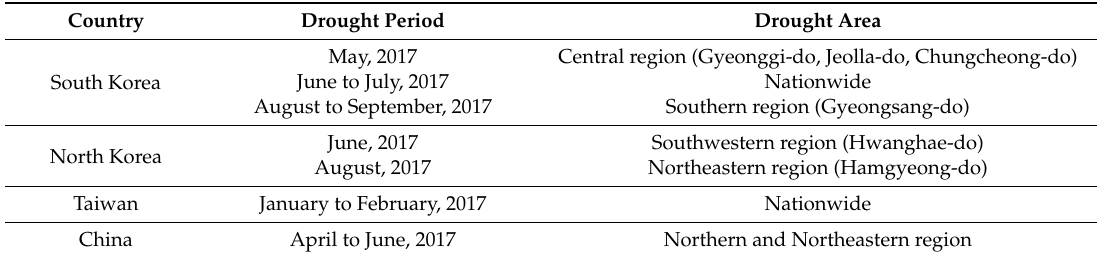
Table 1. Historical extreme drought events in East Asia during recent